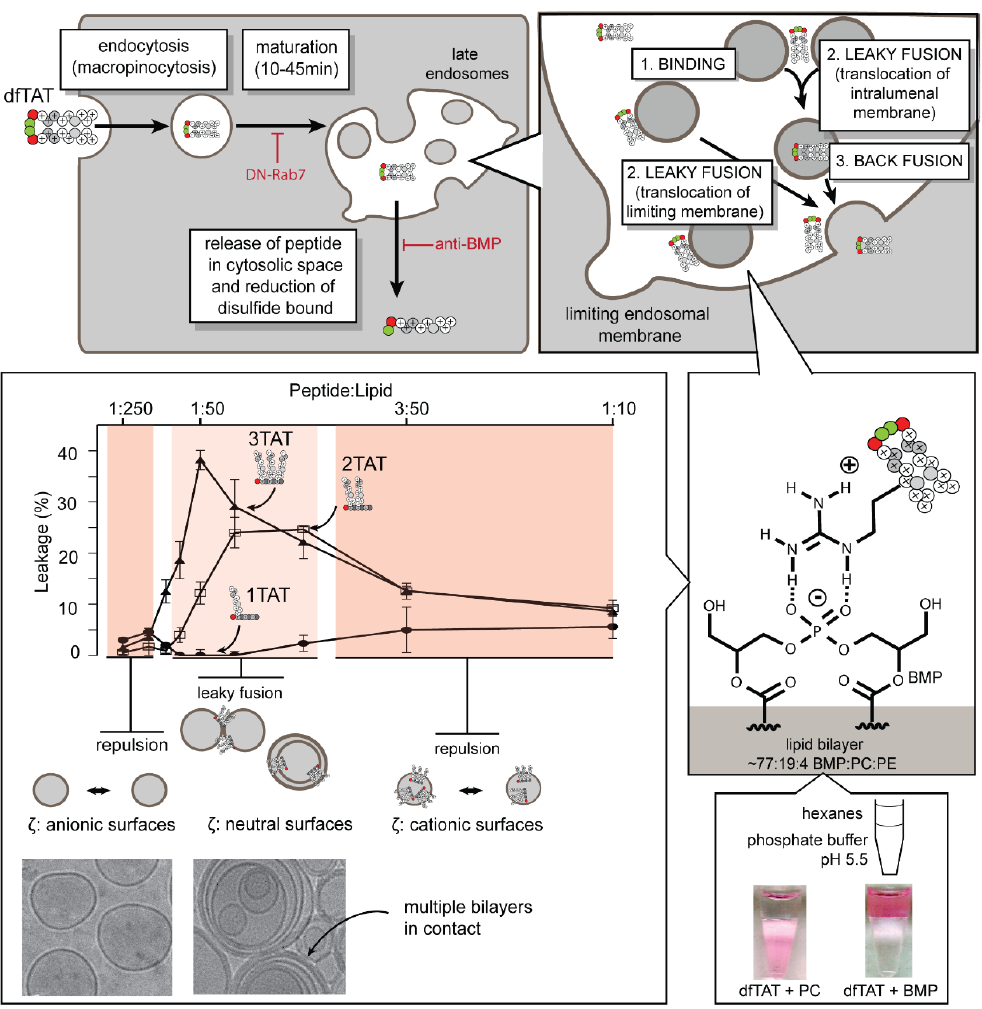
Figure 2. Model of how dfTAT causes the leakage of late endosomes through interactions with the anionic lipid bis(monoacylglycero)phosphate (BMP). dfTAT is taken up by the cell primarily via macropinocytosis. It is then trafficked along the endocytic pathway to late endosomes, which is a process that spans an approximate 10–45 min time window. dfTAT causes the leaky fusion of late endosomal membranes. The nature of this process remains unclear and may hypothetically involve the translocation at the limiting membrane of the late endosomes, or the translocation of intralumenal vesicles. In vitro, dfTAT selectively permeabilizes lipid bilayers that contain the late endosomal anionic lipid BMP. Permeabilization involves leaky fusion, which is a process where peptides displaying several CPP copies (e.g., 2TAT and 3TAT) can neutralize anionic bilayers and bring them into contact. Permeabilization may also relate to the unique ability of dfTAT and BMP to partition into hydrophobic environments. In particular, dfTAT partitions into hexanes with BMP, but not with the lipid phosphatidylglycerol (PG), which is a structural isomer of BMP (hexanes, as shown in the figure, mimic the hydrophobic tails of lipids). PC: phosphatidylcholine; PE: phosphotidylethanolamine.